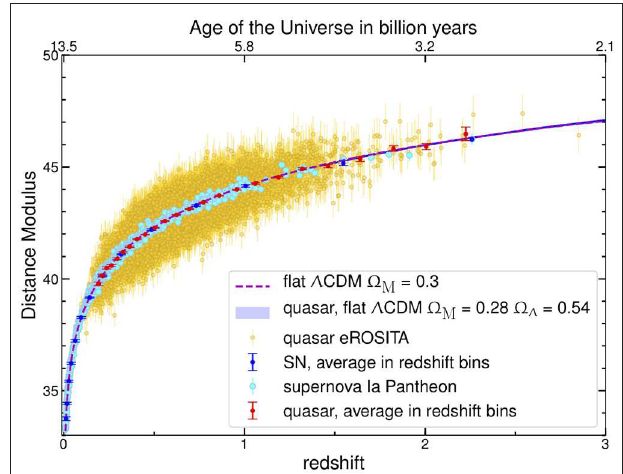
FIGURE 1 | Hubble diagram of eROSITA quasars ( ∼ 11,000, yellow points) and SNe Ia ( Pantheon , cyan points) with 1 σ uncertainties. Red points are the mean (also with 1 σ uncertainties) of the distance modulus in narrow redshift bins for quasars only (shown for visualization purposes). The dashed magenta line shows a flat 3 CDM model fit with (cid:127) m = 0.3. The blue line is the best MCMC fit of the eROSITA quasars (with uncertainties) only for a 3 CDM cosmology where (cid:127) m and (cid:127) 3 are left free to vary (section 3).